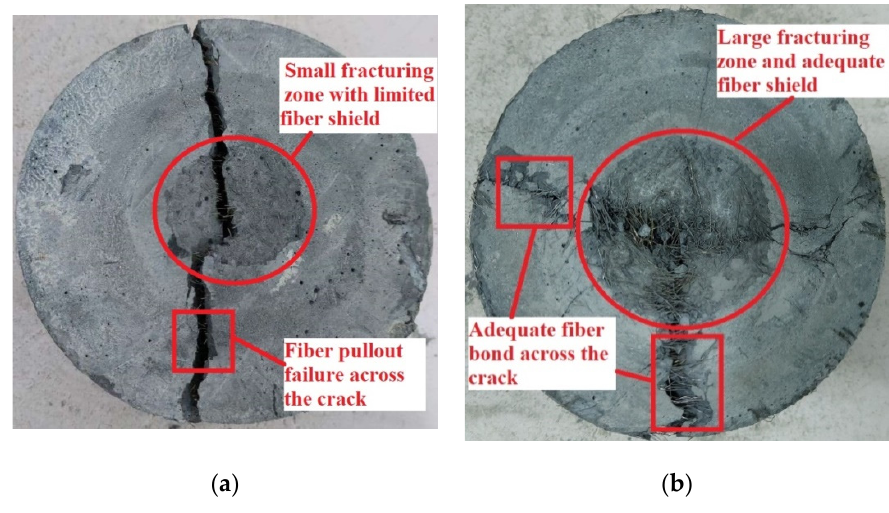
Figure 6. Failure patterns of SF-reinforced specimens. ( a ) S6; ( b ) S15.